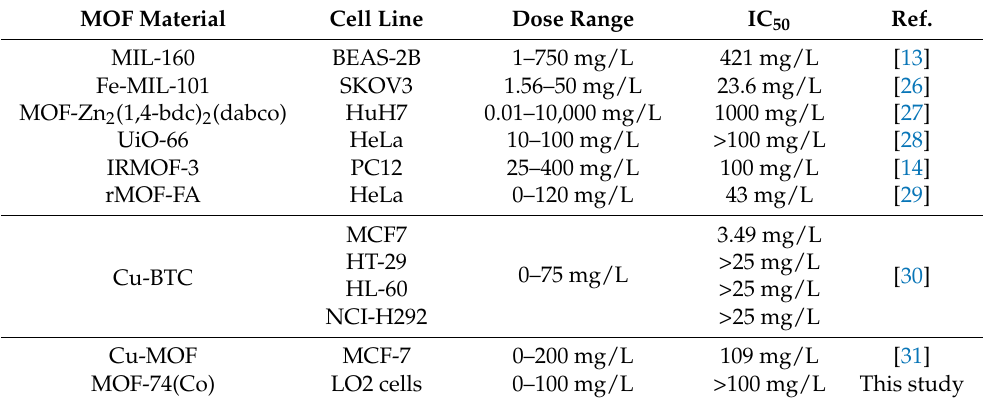
Table 1. Cytotoxicity of different MOF